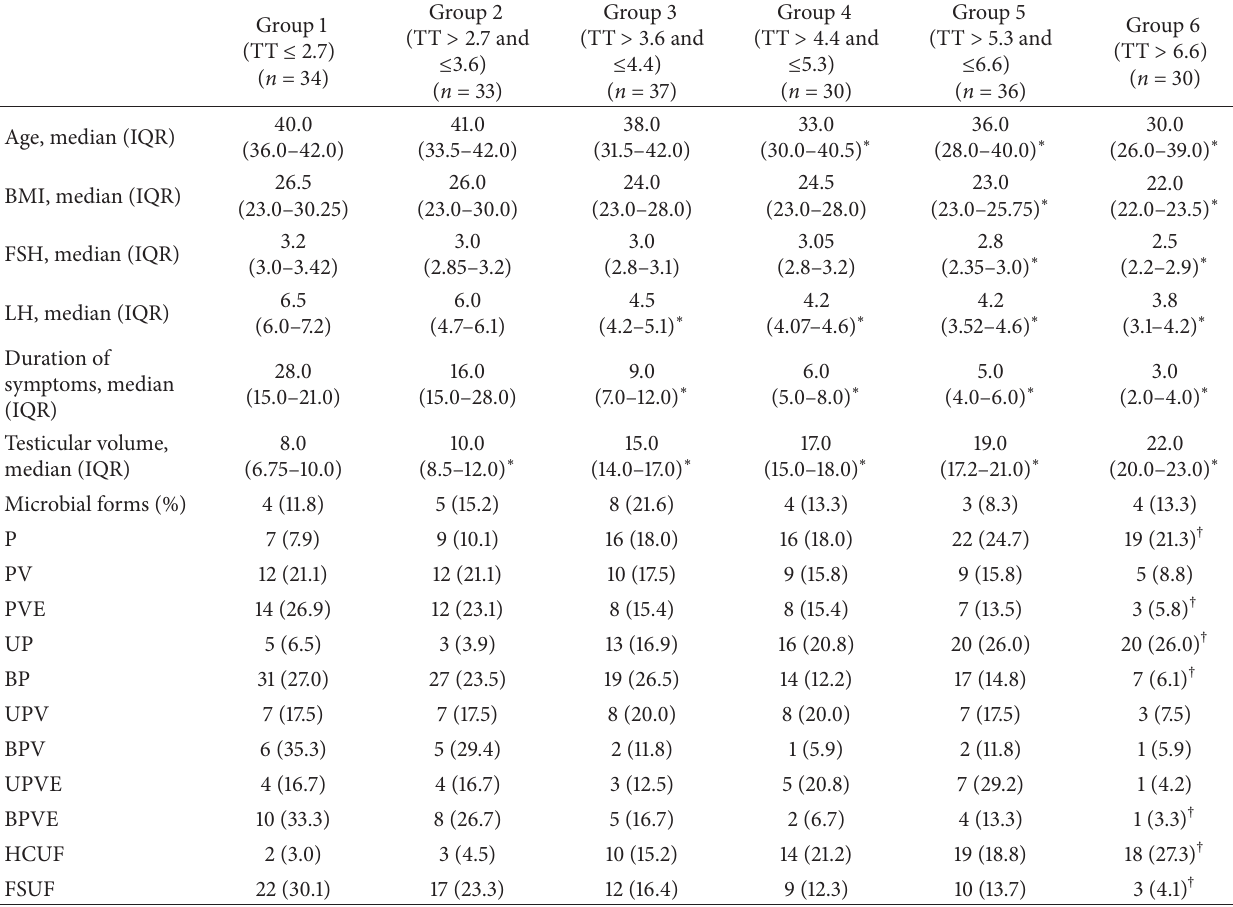
Table 3: Differences between groups divided into sextiles according to the values of